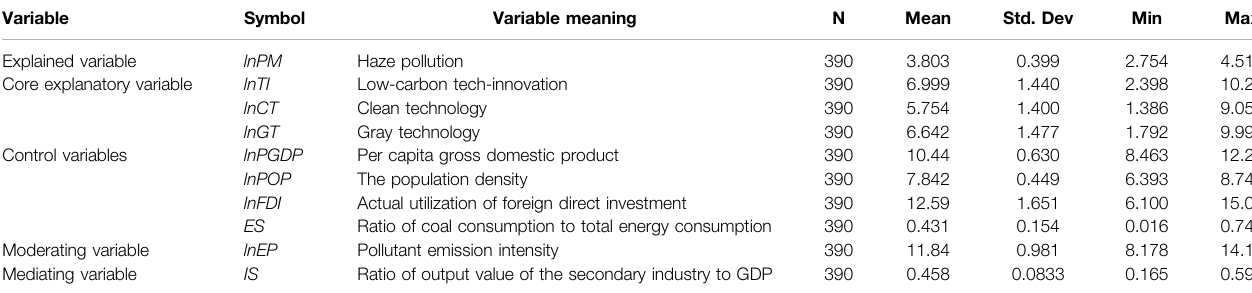
TABLE 1 | Descriptive statistics of variables.